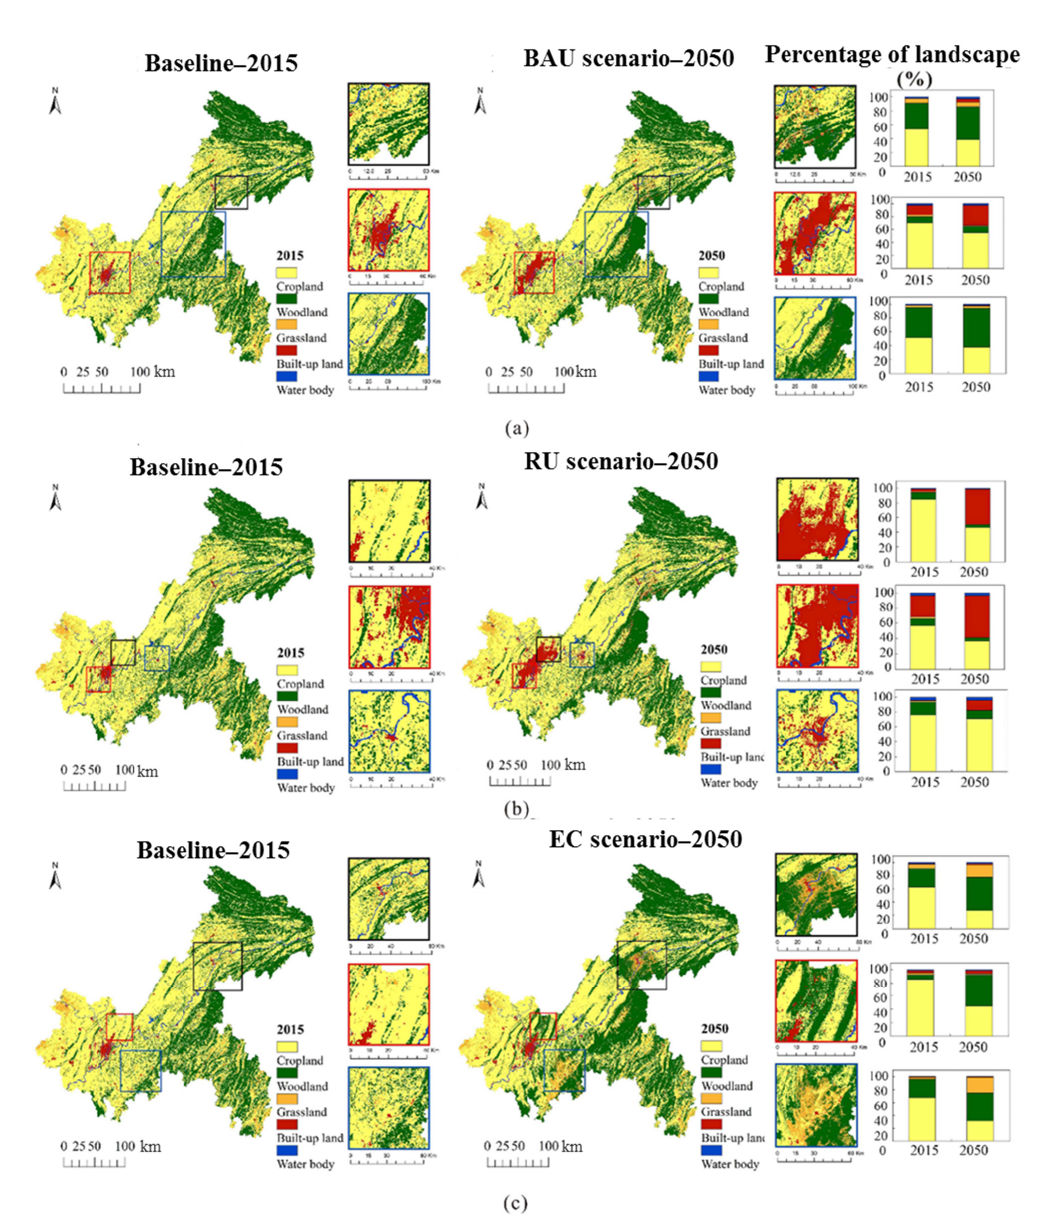
Figure 3. Land use maps in 2015 (baseline) and 2050 under different scenarios. Notes: EC represents ecological conserva ‐ tion. RU represents rapid urbanization. BAU represents business as usual. The three highlighted boxes under each sce ‐ nario represent the most obvious locations of landscape conversion. The right ‐ most column shows comparisons in the percentage of different land use types between baseline and 2050 under the three scenarios. Rapid urban expansion is set to continue in Chongqing during 2015–2050. Built ‐ up area will increase by 202.0%, from 1.18 × 10 5 ha in 2015 to 3.57 × 10 5 ha in 2050 (Figure 3b).